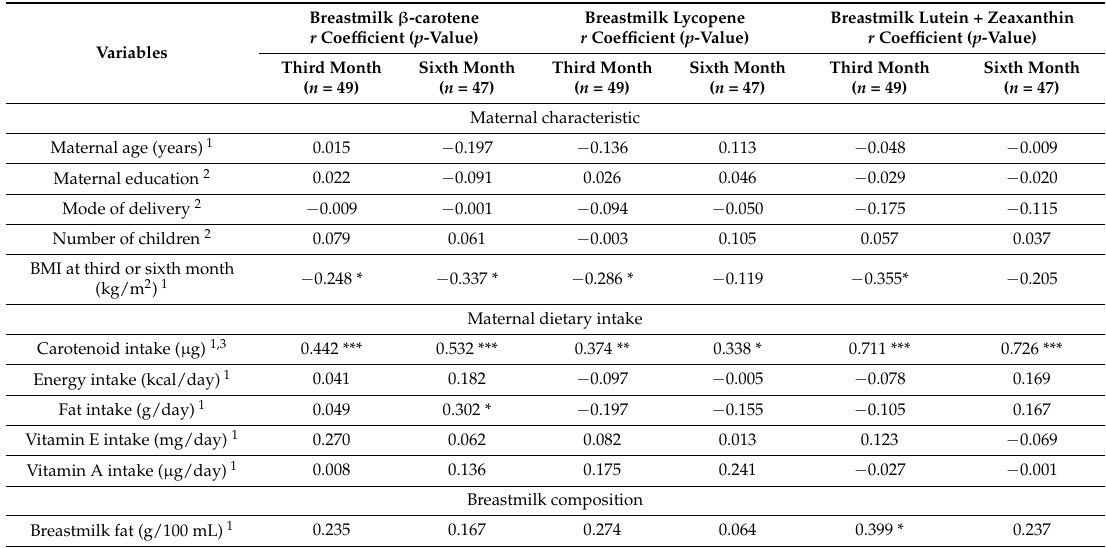
Table 4. Correlations between breastmilk carotenoids and maternal characteristics and dietary